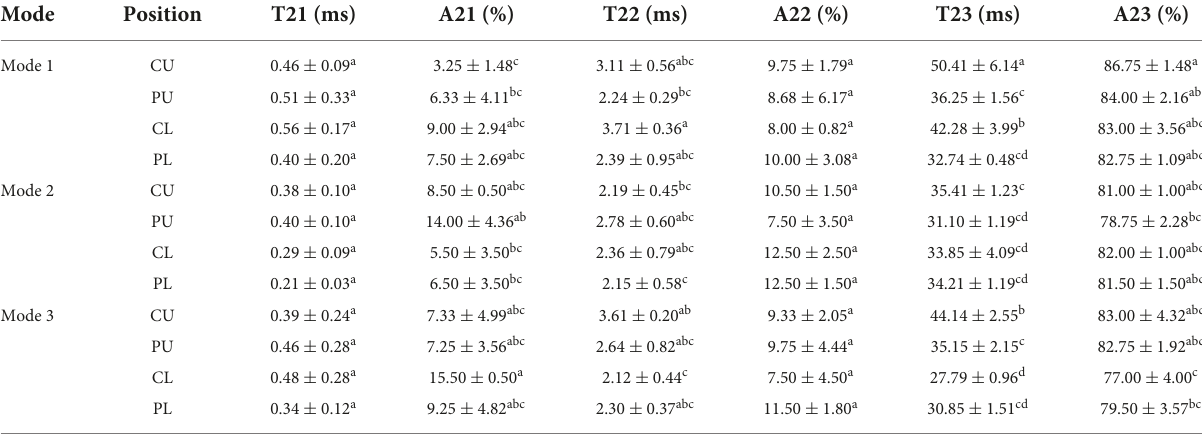
TABLE 1 Moisture characteristics of rice under different heating modes ( n = 6, mean ± STDEV).